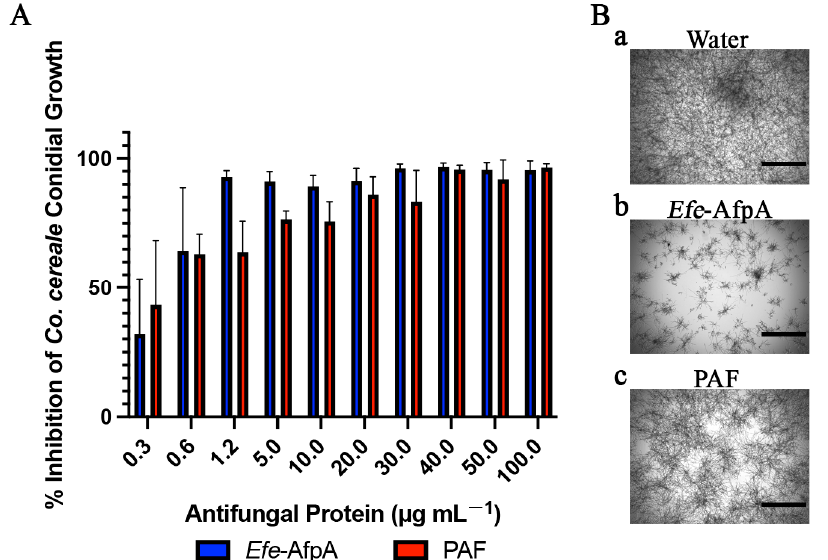
Figure 2. Activity of Efe -AfpA and PAF against Co. cereale conidial growth. ( A ) Growth inhibition of Co. cereale conidia treated with increasing concentrations of either Efe -AfpA or PAF incubated at room temperature for 48 h. The data presented are the means and standard deviations of three replicates. ( B ) Microscopy of Co. cereale conidia treated with water or 1.2 μ g mL − 1 of either Efe -AfpA or PAF. Bars are 750 μ m.